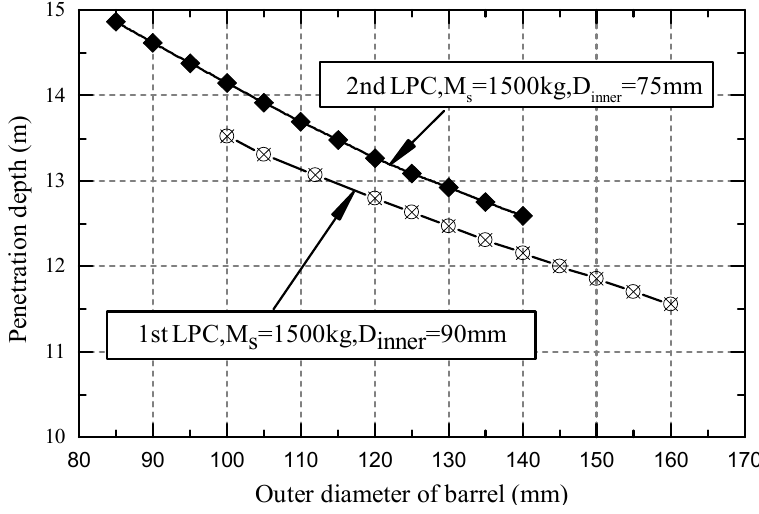
Figure 14. Variations of penetration depth vs. different